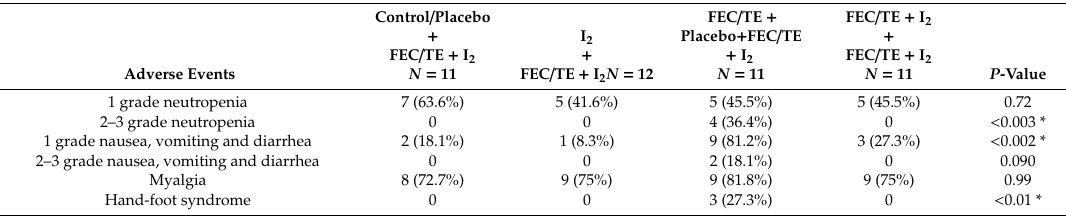
Table 1. Treatment-related clinical adverse events.